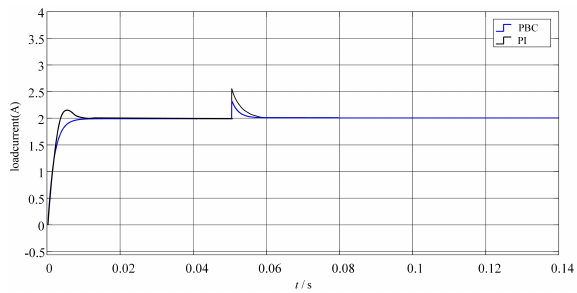
Fig. 13. Rectifier output current during load fluctuation